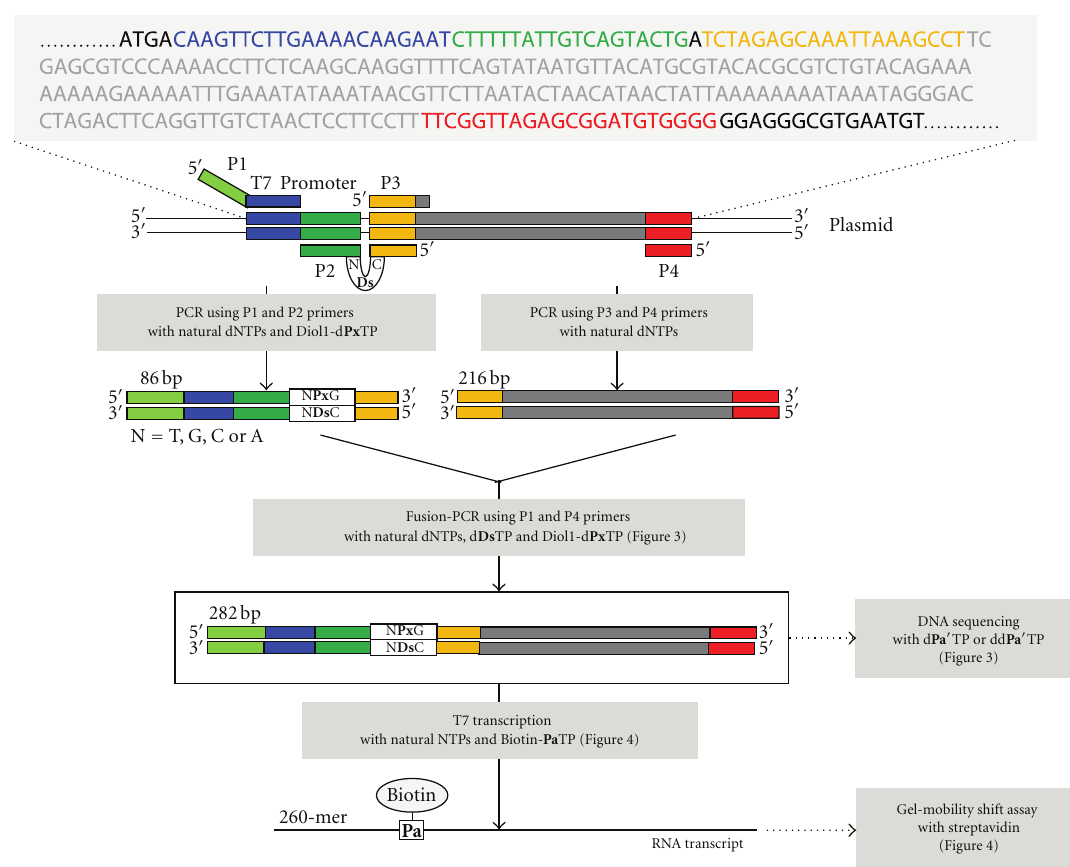
Figure 2: Experimental scheme of PCR amplification and transcription by a two-unnatural-base-pair system for site-specific biotin labeling of RNA molecules. DNA fragments containing the Ds - Px pair at the internal positions were prepared by a fusion PCR method. The original plasmid sequence, used as the PCR template, is shown at the top. The C Ds N sequence (N = T, G, A, or C) in the P2 primer is integrated into the 86-bp DNA fragments. The 282-bp products generated by fusion PCR were used as templates for T7 transcription with Biotin- Pa